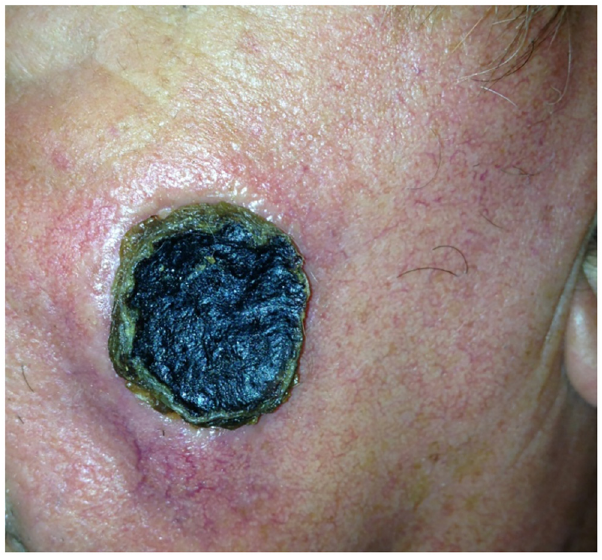
Fig 1. Anthrax-like cutaneous lesion on left check of 70-year-old male Florida